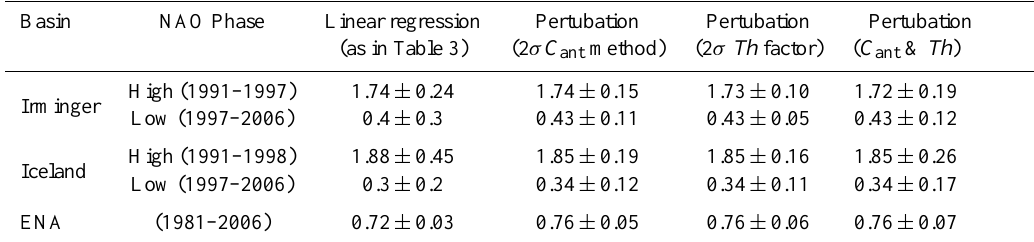
Table B1. Standard errors of C ant inventory estimates calculated considering the main sources of uncertainty involved, i.e., the uncertainty of C ant concentration values and the uncertainty in layer thickness estimation (Appendix A1).